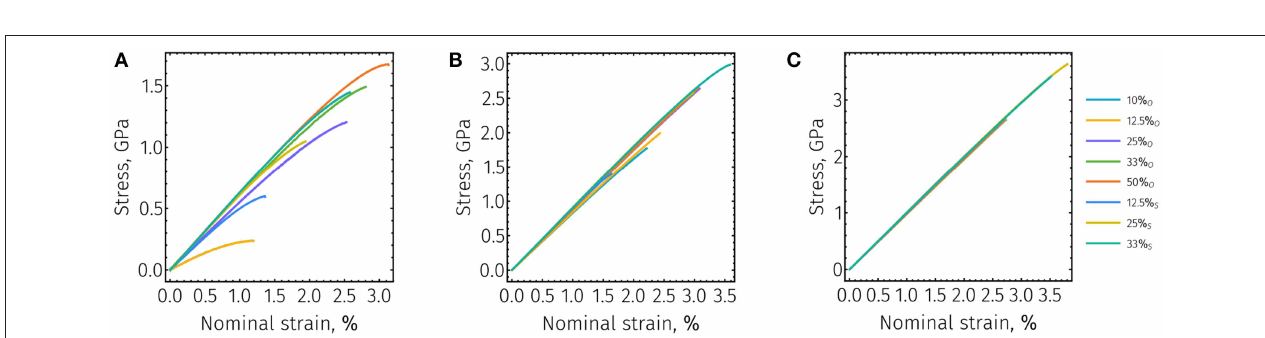
FIGURE 3 | Stress strain responses of CNC films with approximate base fiber lengths (A) L = 50nm, (B) L = 150nm, and (C) L = 300nm. Colors in each plot correspond to various fiber ordering schemes. x % O and x % S refer to regular and staggered offset structures with x % offset between neighboring fibers, respectively.